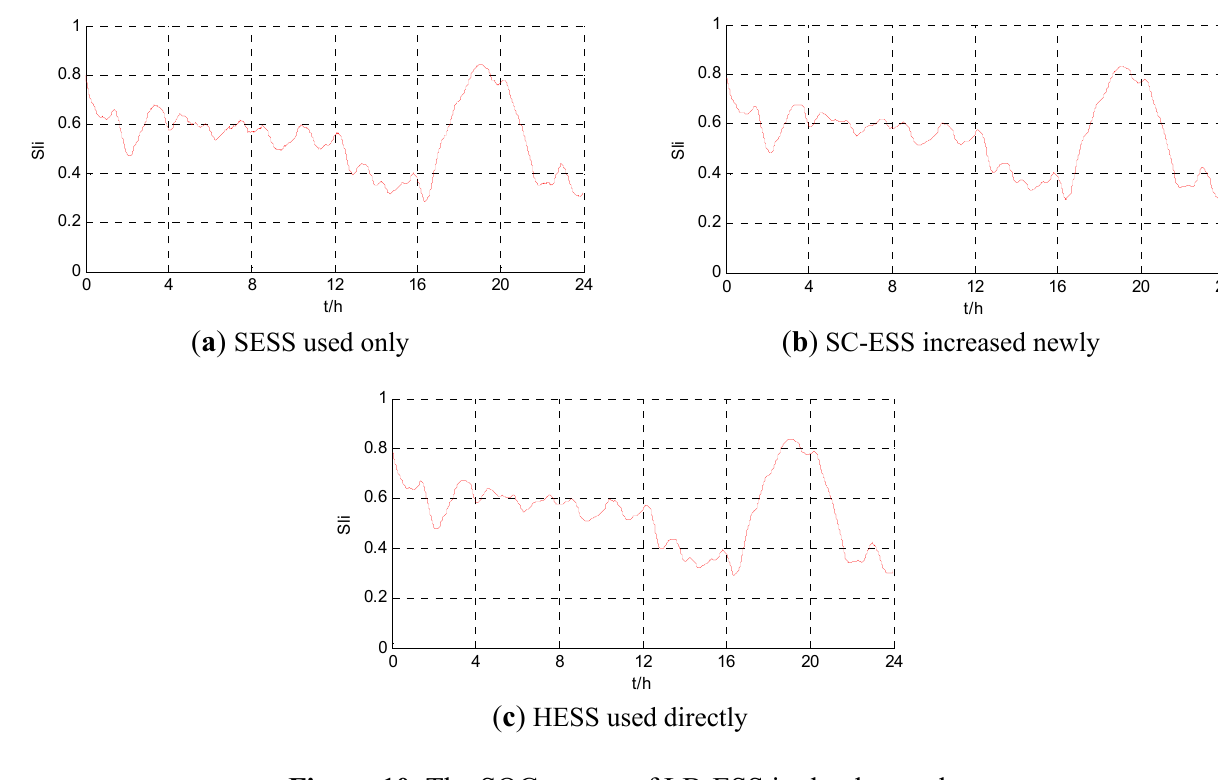
Figure 10. The SOC curves of LB-ESS in the three